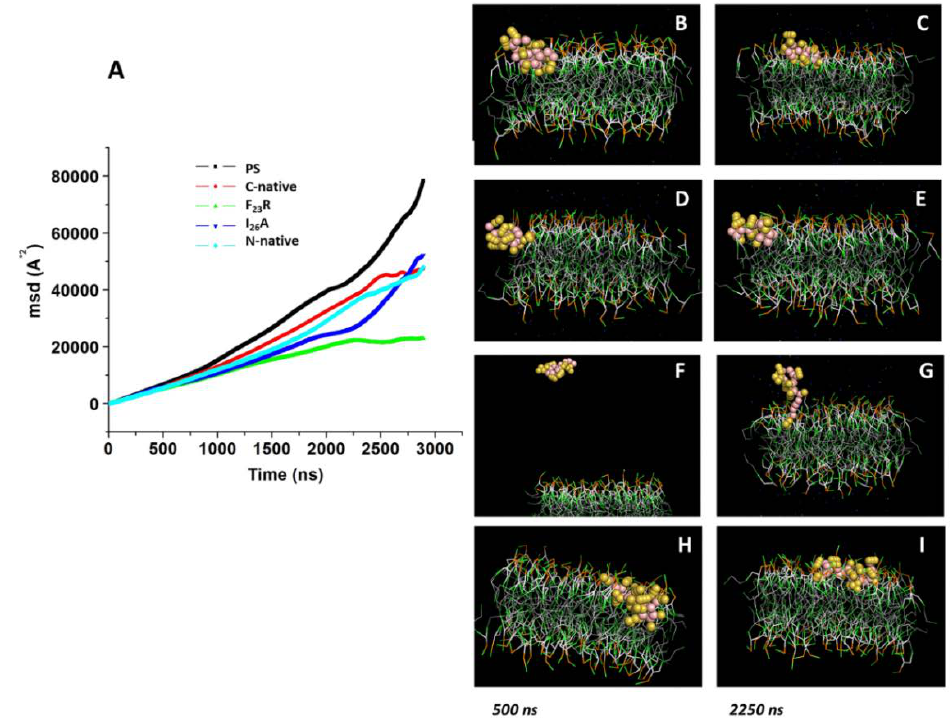
Figure 7. Displacement of peptides derived from the IAPP C-terminal on the z -axis of PS-bilayer. ( A ) MDS values on PS bilayer under the incubation of peptides-derived of IAPP through 3000 ns of simulation. Representative snapshots of the PS model with the C-native segment at 500 ns ( B ) and 2250 ns ( C ). Snapshots of F 23 R ( D , E ), I 26 A ( F , G ), and the N-native segment ( H , I ) under the same conditions.